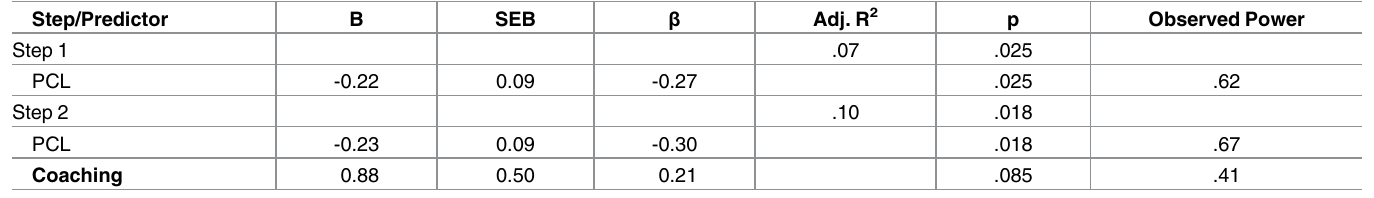
Table 4. Regression analysesfor hypothesis 4: Criterion variable for all analysesis Job in General (job satisfaction).